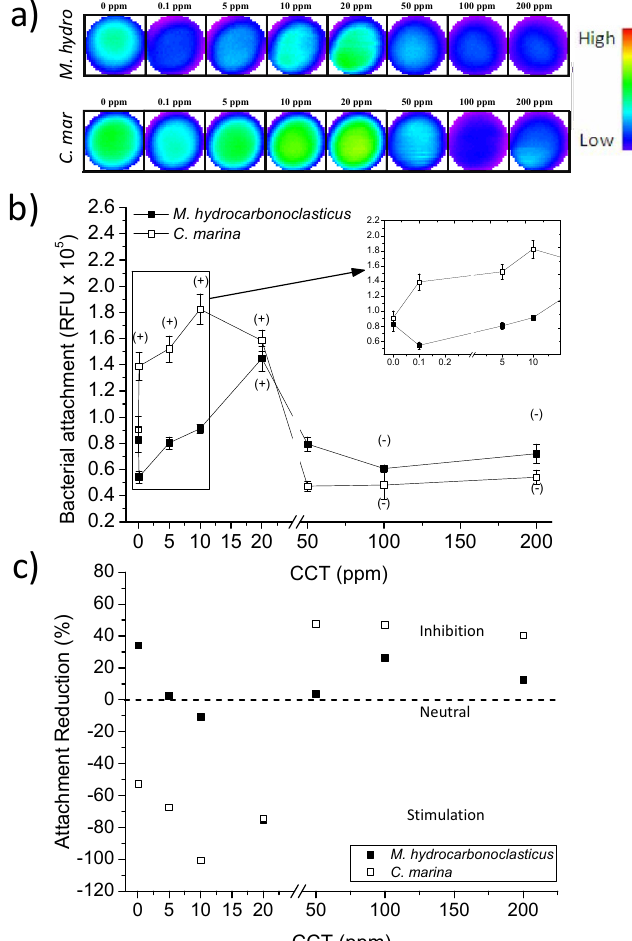
Figure 5. The effect of C. crispus on C. marina and M. hydrocarbonoclasticus biofilm accumulation, where: ( a ) is the well scan images of individual wells (scan matrix dimension: 30 × 30, equivalent to a resolution of 213 μ m × 213 μ m; scan width: 6 mm); ( b ) End point fluorescence intensity (units: relative fluorescent units, RFU). Positive/negative (+/ − ) symbols indicate a significant increase (+) or decrease ( − ) in the attachment of the species when compared with the control at 95% confidence intervals. Syto9: excitation λ = 485 nm, emission λ = 510 nm. Error bars ±SD; ( c ) Attachment reduction according to RFU values, as a percentage of the control (0%, dashed line), where negative values indicate increased attachment and positive values, reduction. CCT, C. crispus toluene